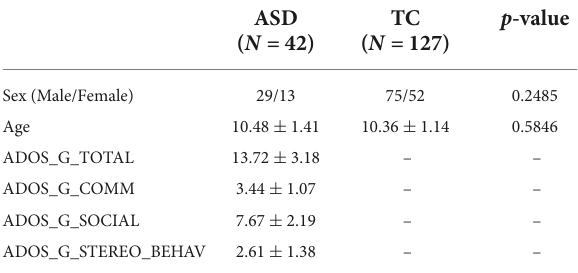
TABLE 1 Demographic and clinical data of the